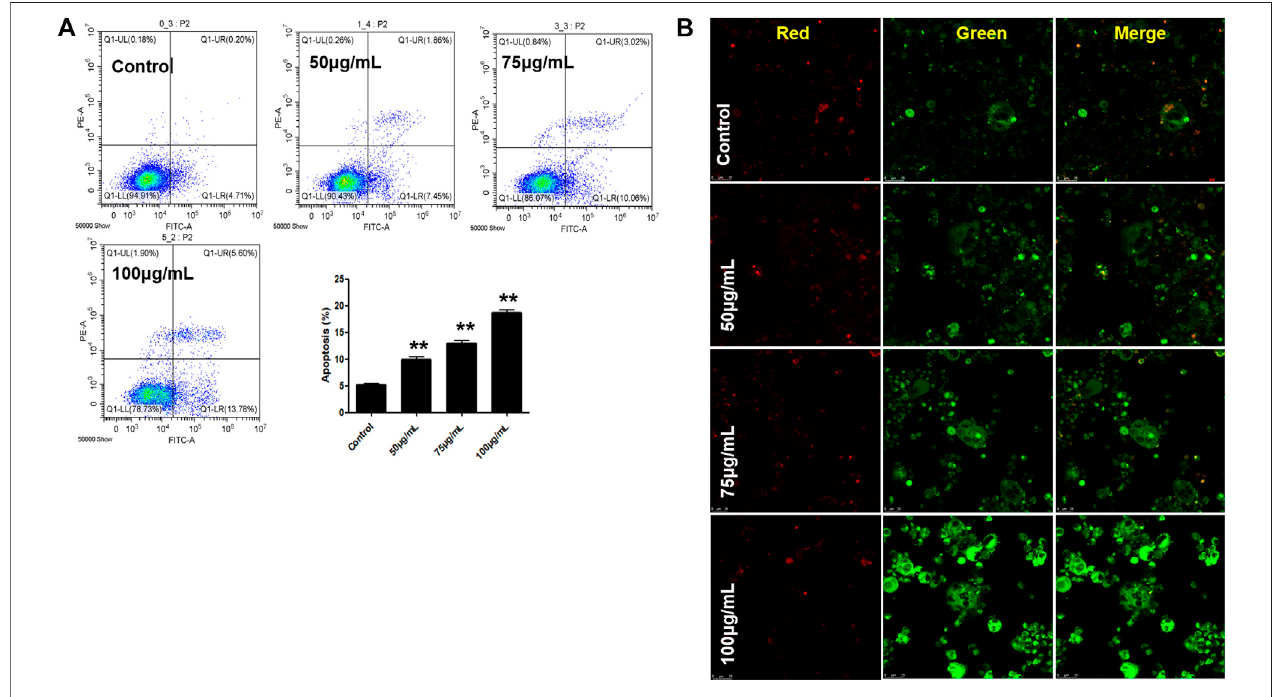
Frontiers in Pharmacology |